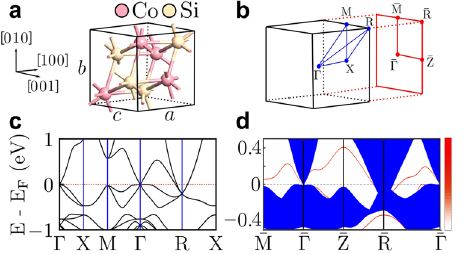
Fig. 1 Crystal structure and band structure of bulk and semi- in fi nite CoSi. a Unit cell of CoSi with lattice constants a = b = c = 4.438 Å. b Corresponding bulk Brillouin Zone (BZ) and its projection along the (100) surface (shown in red). c Bulk electronic band structure of CoSi. d Surface-state spectral weight (in red) of a (100)-oriented semi-in fi nite CoSi slab with the color scale in arbitrary unit. The blue area indicates the bulk bands projected on the (100) surface.